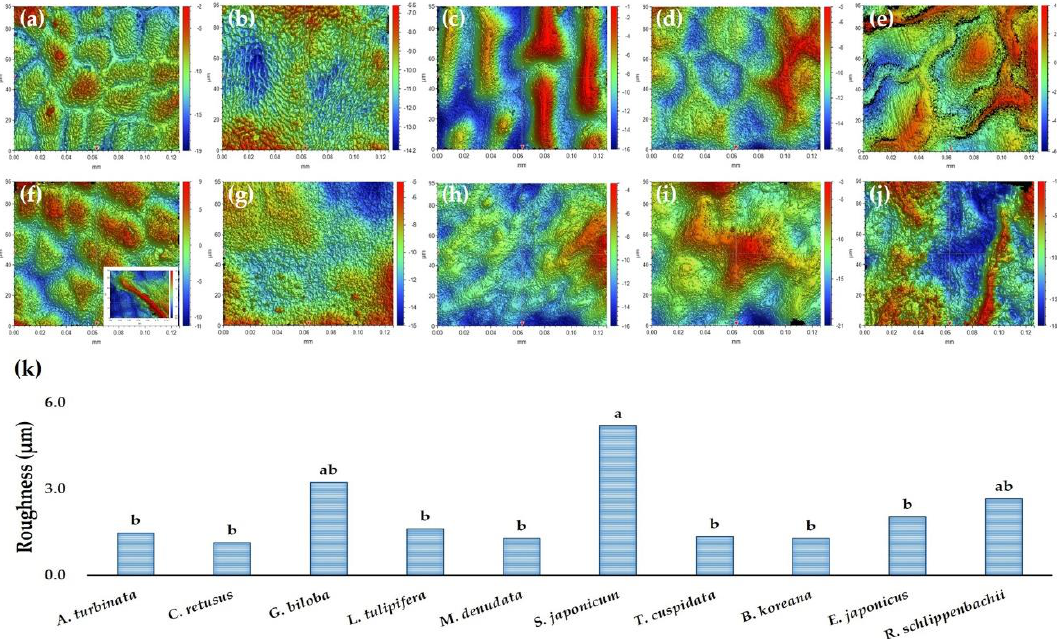
Figure 9. 3D surface topography reconstructions using non-contact surface profiler showing surface roughness on adaxial leaf surfaces: ( a ) Aesculus turbinata ; ( b ) Chionanthus retusus ; ( c ) Ginkgo biloba ; ( d ) Liriodendron tulipifera ; ( e ) Magnolia denudata ; ( f ) Styphnolobium japonicum ; ( g ) Taxus cuspidata ; ( h ) Buxus koreana ; ( i ) Euonymus japonicus ; ( j ) Rhododendron schlippenbachii ; ( k ) Roughness data among ten species distinguished by microsized structures areas in the replicated surfaces (50× magnification). Note: ( f ) and ( j ) images display long non-glandular trichomes on adaxial leaf surfaces. The same lowercase letters above a bar graph ( k ) represent non-statistically significant differences among species using Tukey’s post-hoc analysis with 95% confidence level, p > 0.05 ( n = 30).